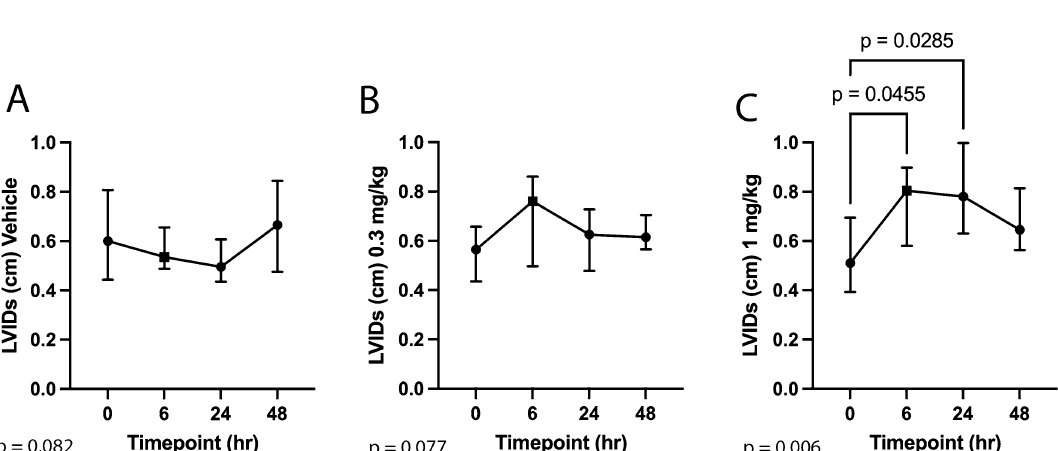
Figure 2. Left ventricular systolic internal dimension (LVIDs) at 6-, 24-, and 48-h post administration of treatment. ( A ) Vehicle. ( B ) Aficamten (0.3 mg/kg). ( C ) Aficamten (1.0 mg/kg). The median is denoted at each time point and the whiskers represent the interquartile range. The overall P value is denoted on the bottom left of each graph. Where pairwise comparisons were significant they are shown with their respective P values.